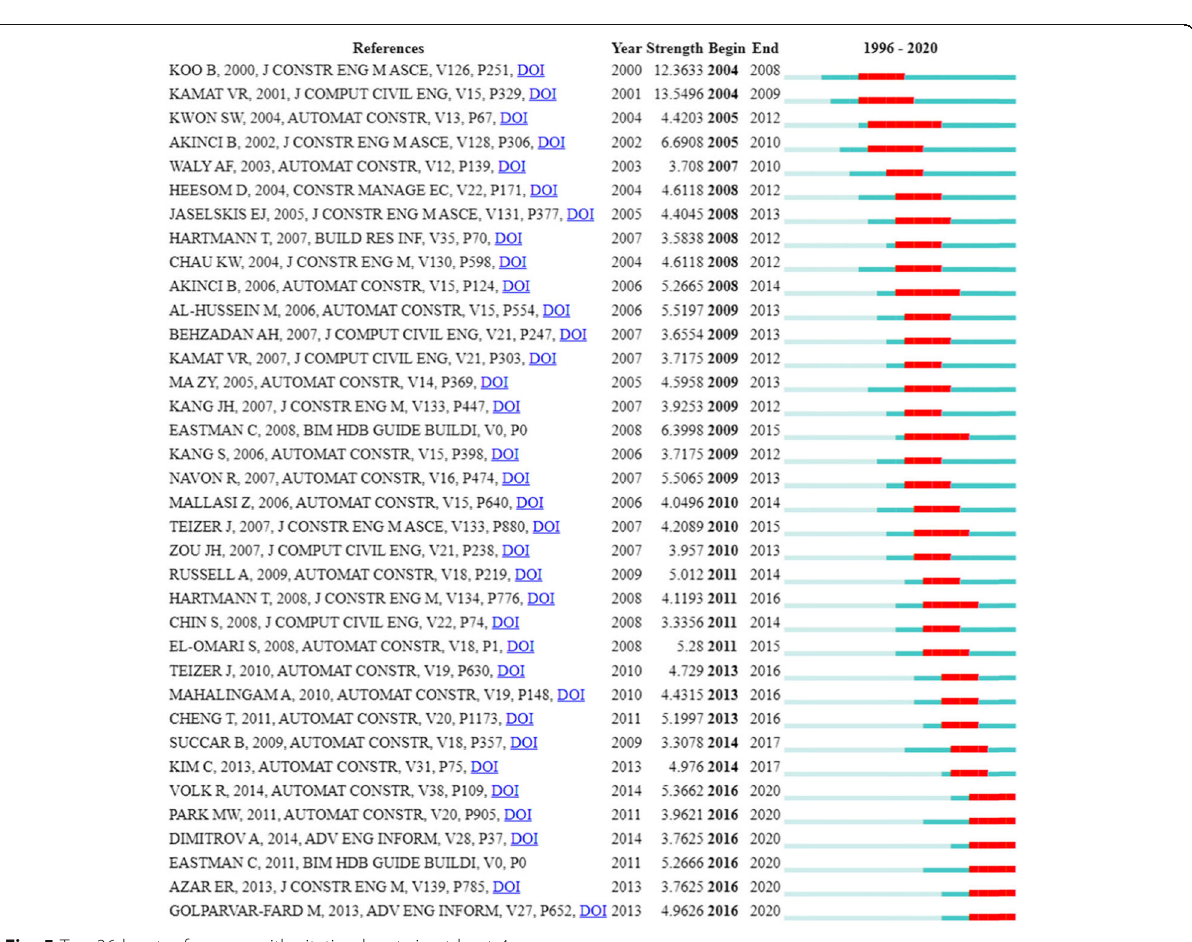
Fig. 5 Top 36 burst references with citation bursts in at least 4